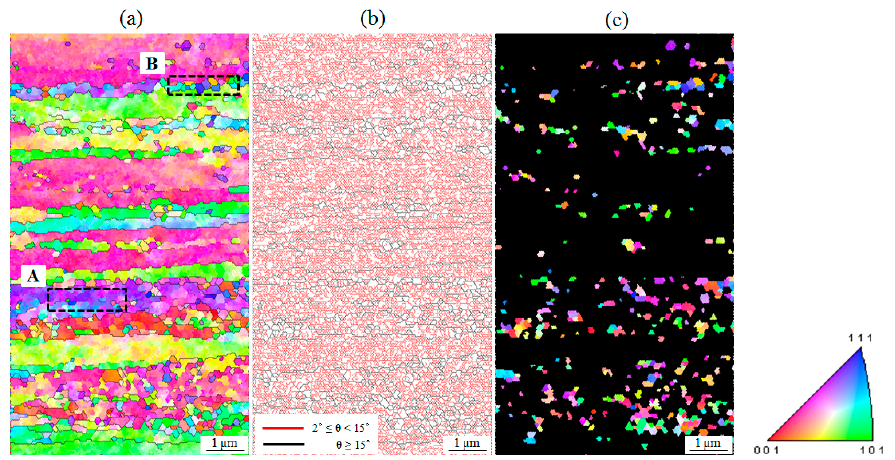
Figure 2. ( a ) IPF (Inverse Pole Figure), ( b ) grain boundaries and ( c ) partitioned IPF maps of the DSR- deformed 6061 Al alloy. DSR-deformed 6061 Al